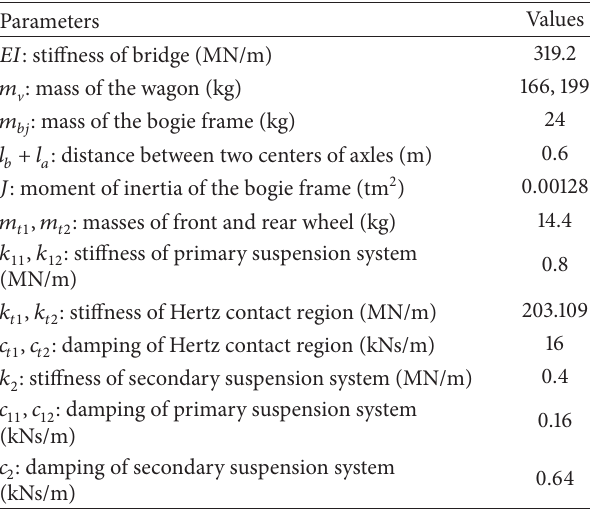
Table 2: Bogie and bridge parameters for 1: 5 scaled roller